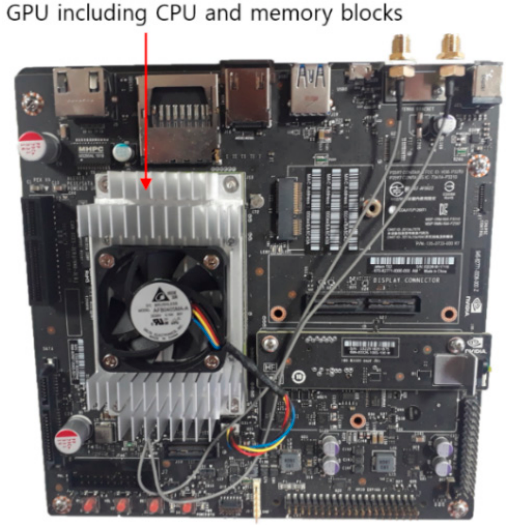
Figure 7. Jetson TX2 embedded system.